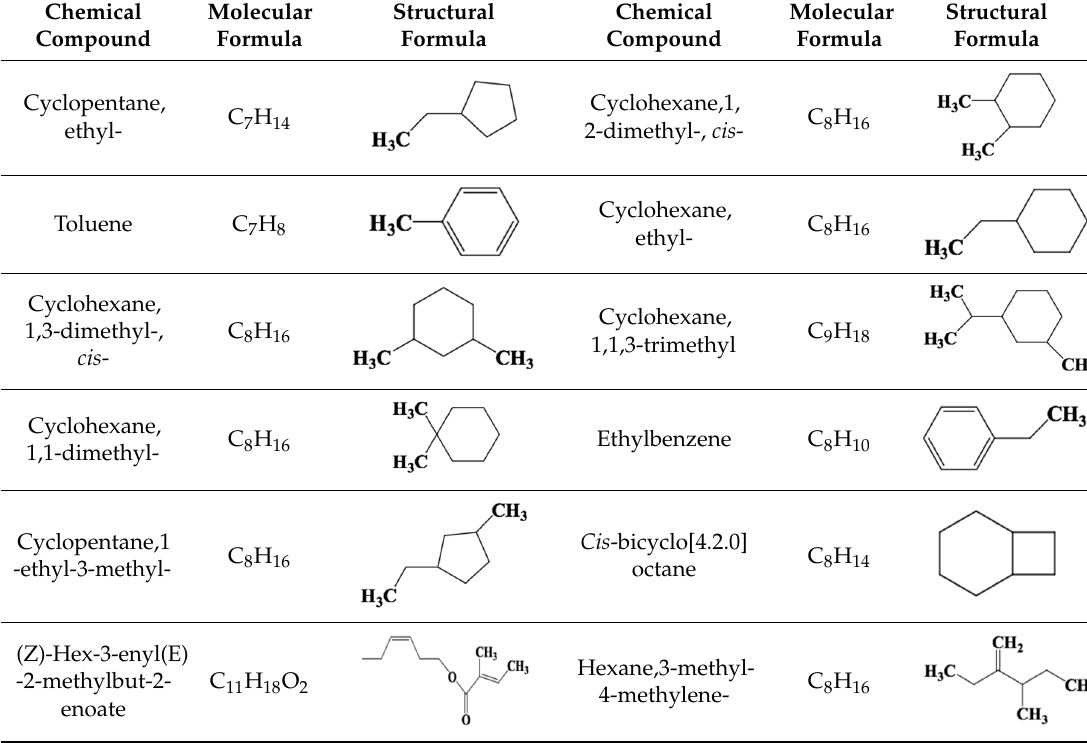
Table 2. Extractive content of different extraction methods (wt %).